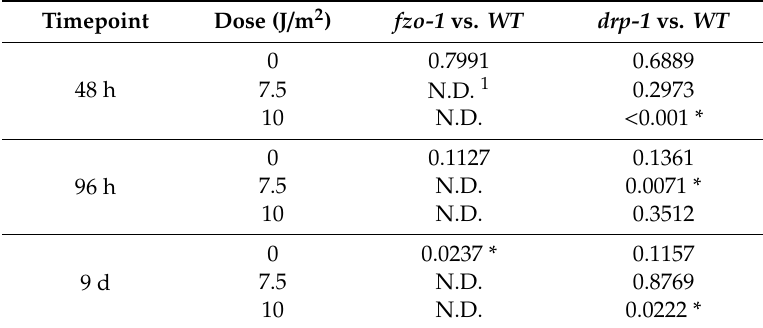
Table 1. p -values (Fisher’s exact test) for strain comparisons ( drp-1 and fzo-1 vs. wild-type (WT)) after UVC exposure in L1 larval C. elegans